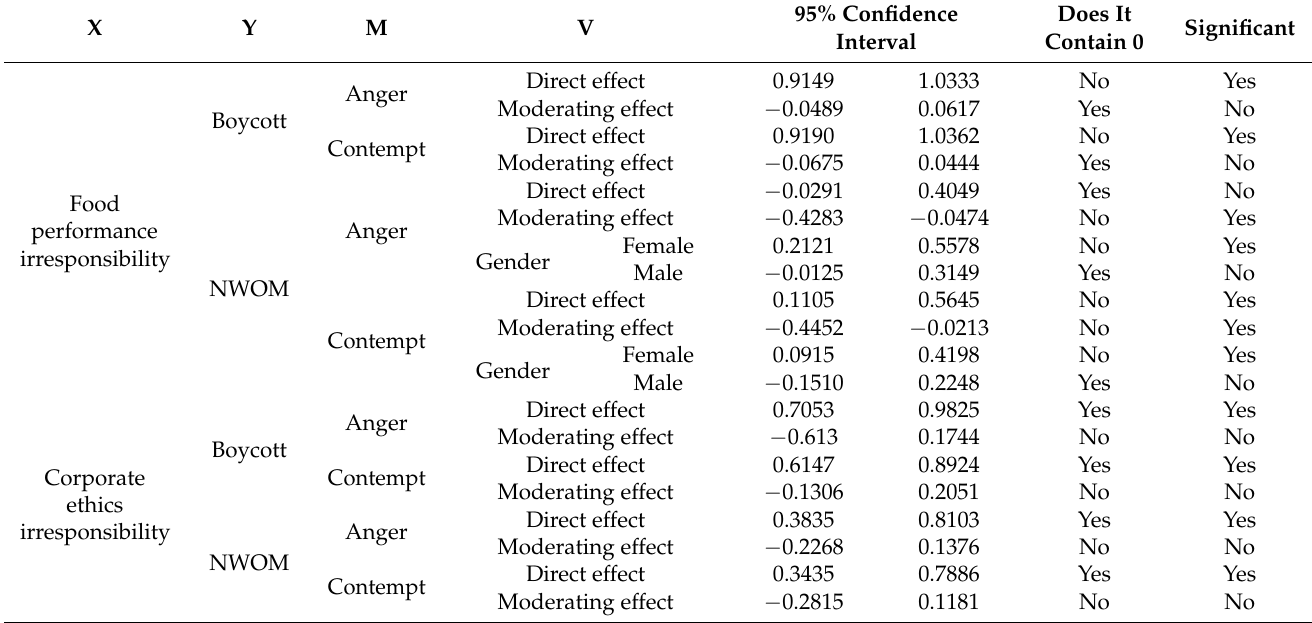
Table 7. The moderating role of gender in terms of CSI, negative moral emotions, and consumer